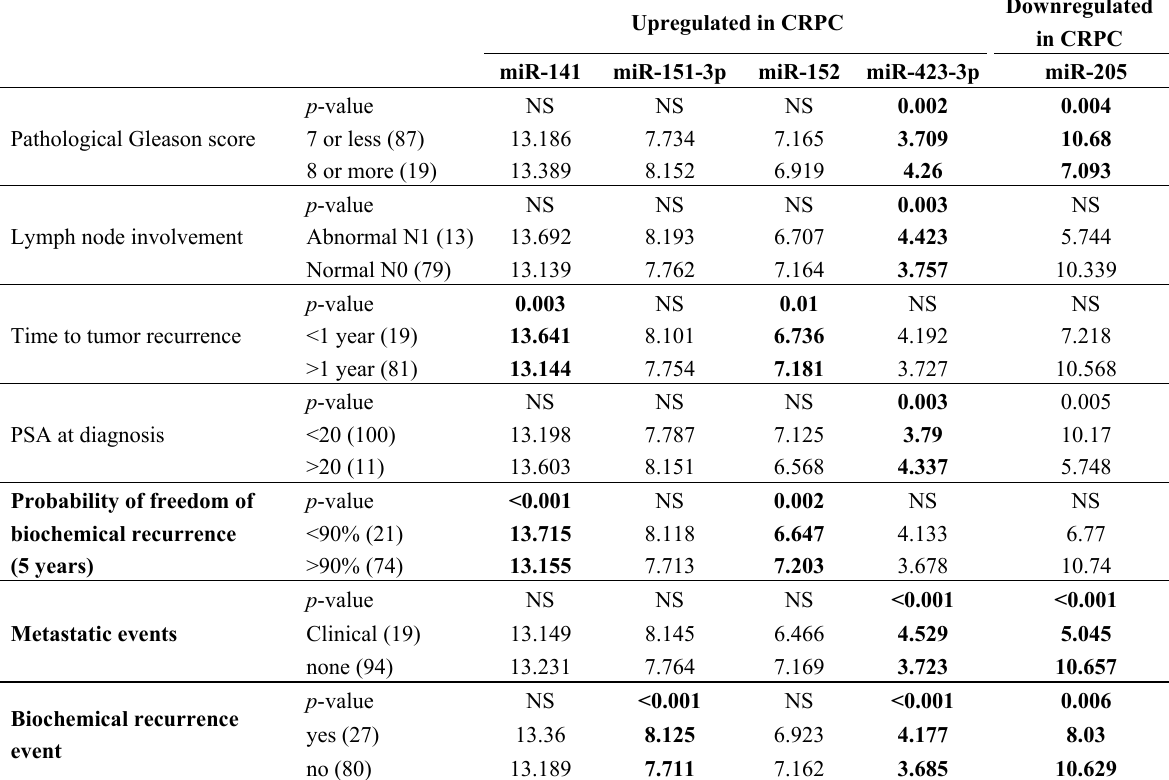
Table 3. Association of miRNAs with clinical parameters of PCa progression. We analyzed the correlation between clinical parameters and expression levels of 11 miRNAs (3 downregulated and 8 upregulated in mCRCPC versus localized PCa plasma samples). Selected miRNAs were the ones not previously correlated with PCa progression. p values are considered significant when p < 0.05/11 (Bonferroni correction for multiple comparisons). For each parameter, we show the p value (NS, non-significant) and the absolute value of gene expression in the 2 sub-categories (e.g., low versus high Gleason score). For each sub-category, the number of patients analyzed is shown in brackets. Significant results are presented in bold font. Biochemical recurrence is defined as PSA ≥ 0.2 ng/mL on two occasions after prostatectomy.